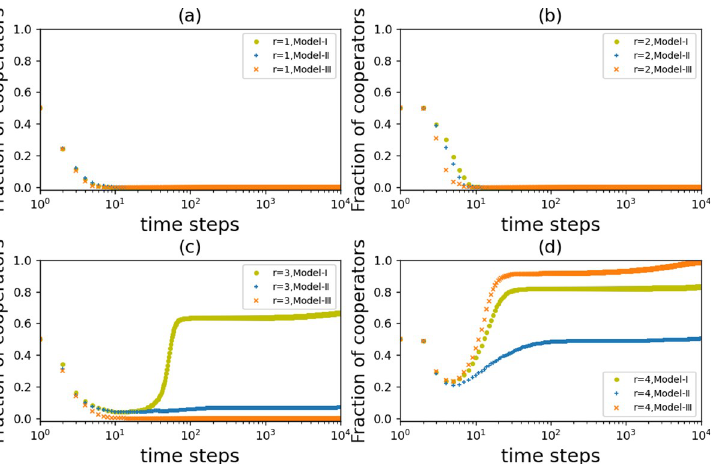
Fig 6. The fraction of cooperators with respect to time for three different partner switching mechanisms. (a) Synergy factor r = 1; (b) r = 2; (c) r = 3; (d) r = 4. When r = 1 and r = 2, the cooperation reward is too low, defectors quickly spread and finally become dominant over the whole population. For Model-I , the level of cooperation was higher both when defection dominated ( r = 3 ) and cooperation dominated ( r = 4). Model-II and Model-III have disadvantages of not being conducive to spreading cooperative and protecting cooperator, respectively. Parameters: N = 10000, T = 20, α = 5, ^ k ¼ 4 , β = 5, and ω = 0.1.